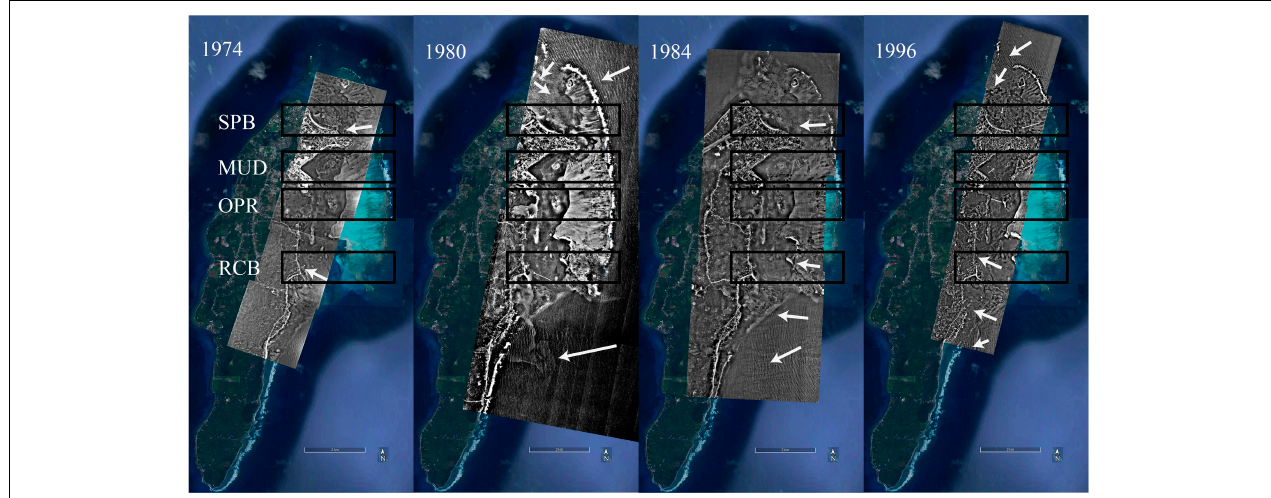
FIGURE 2 | Wave direction (white arrows) in sampling sites (black rectangles: MUD, island harbor; OPR, Old Point Regional Park of Mangrove; RCB, Rocky Cay bay; SPB, Sprat bay), using aerial photographs from the years 1974, 1980, 1984, and 1996 (Source: Instituto Geográfico Agustin Codazzi